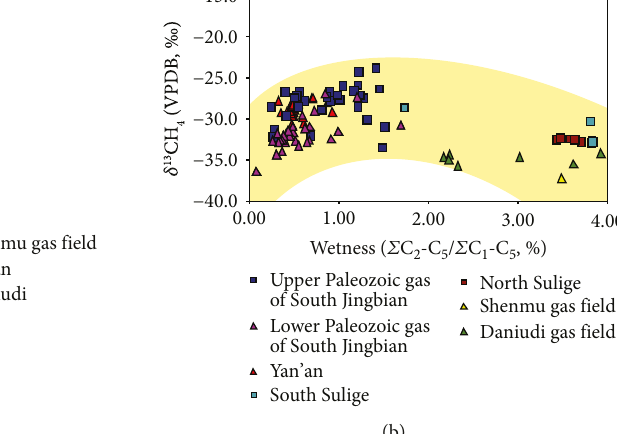
H versus gas wetness (modi fi ed from [15]); (b) detailed plot of δ 13 C-CH 3 8